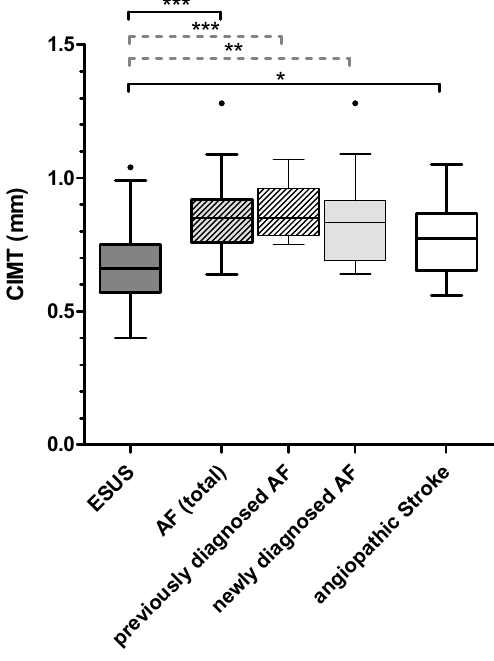
Figure 3. Group differences in CIMT. AF (total) subsumes previously and newly diagnosed AF. * p ≤ 0.05; ** p ≤ 0.01; *** p ≤ 0.001.